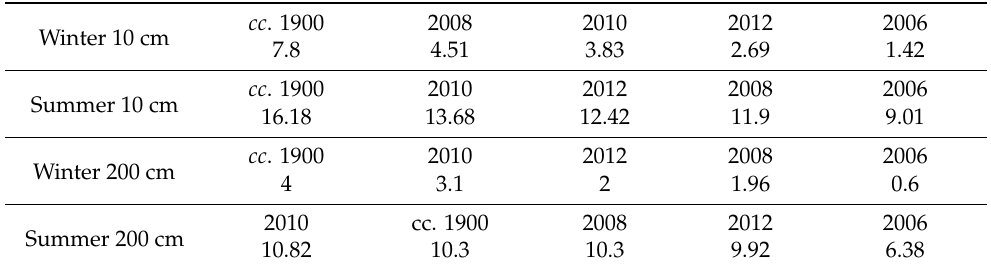
Table 3. Sample sites in ascending order based on mean infiltration in winter and summer at both 10 and 200 cm